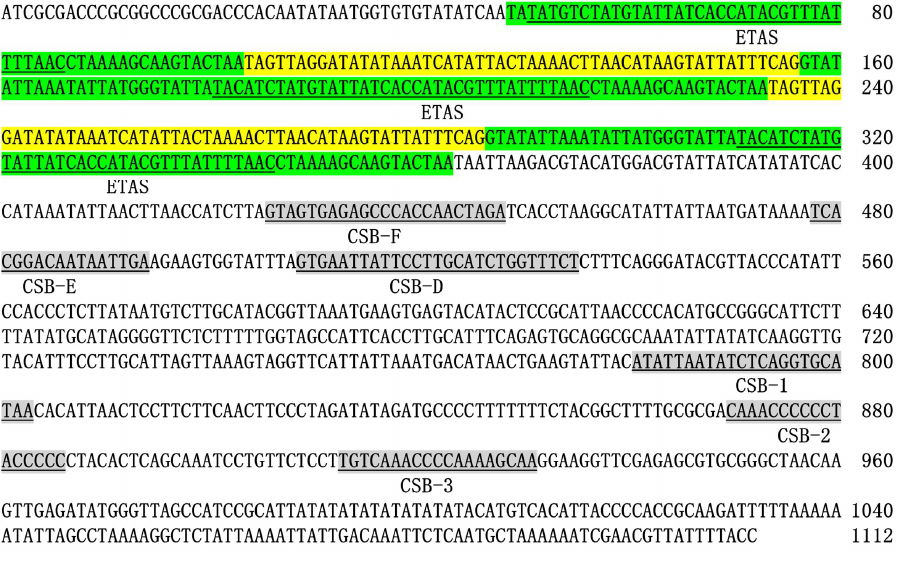
Figure 3. D-loop of Phoxinus cf. phoxinus from the Heilongjiang River, with special reference to im- portant regulatory elements that are underlined and shaded. Conservative domain and variable domain of repetitive unit are shown in green and yellow.